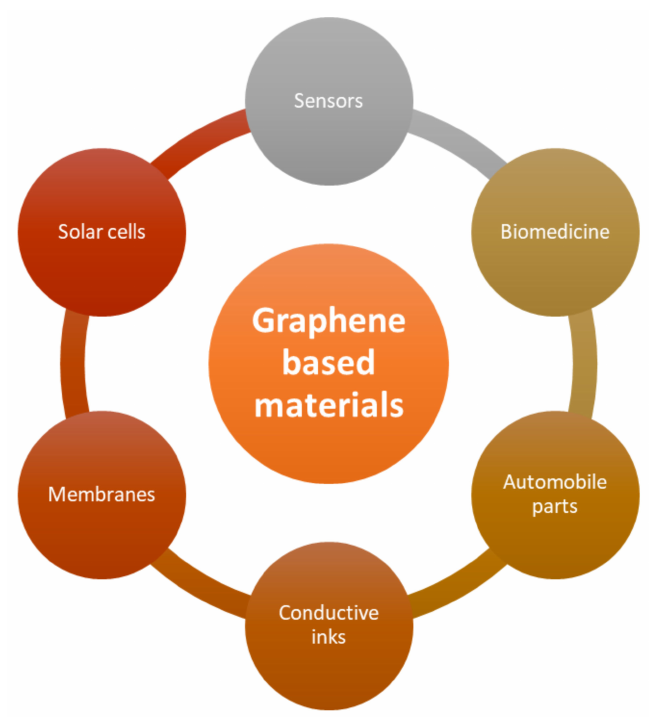
Figure 13. Graphene materials’ promising application